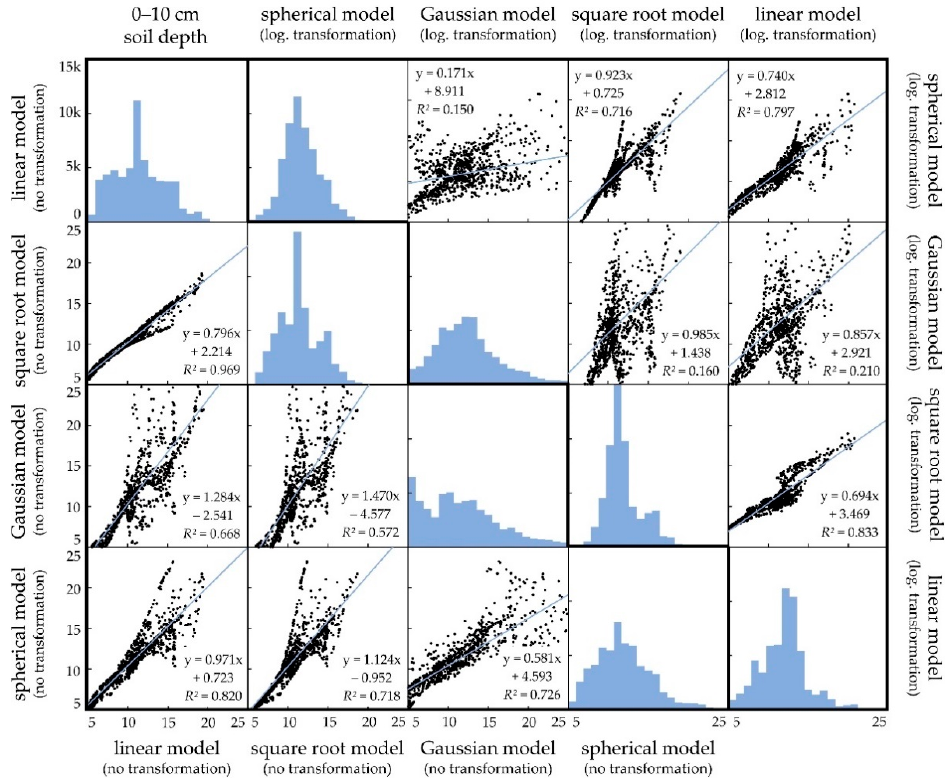
Figure 6. Combined scatterplot of interpolation results in 0–10 cm soil depth.